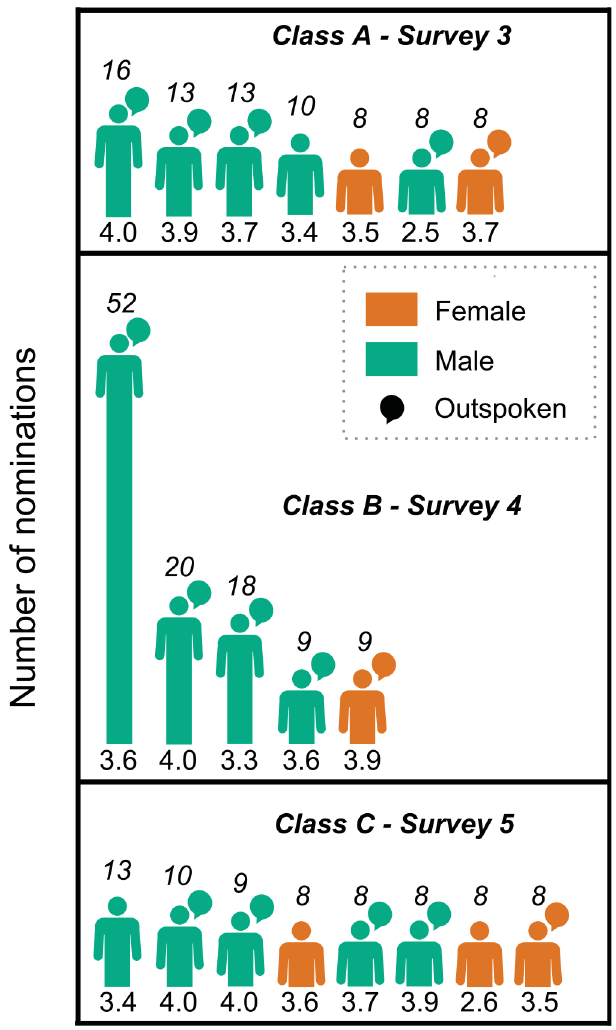
Fig 3. The most renowned students in each class tend to be male. Students with the five highest numbers of nominations are depicted for each class. The numbers above each student represent how many nominations that student received, while the numbers below each student represent their grade point average earned in the course out of 4 points. These data come from the last surveys administered in Classes A, B, and C, and represent our best estimate for the perceptions developed by the end of each